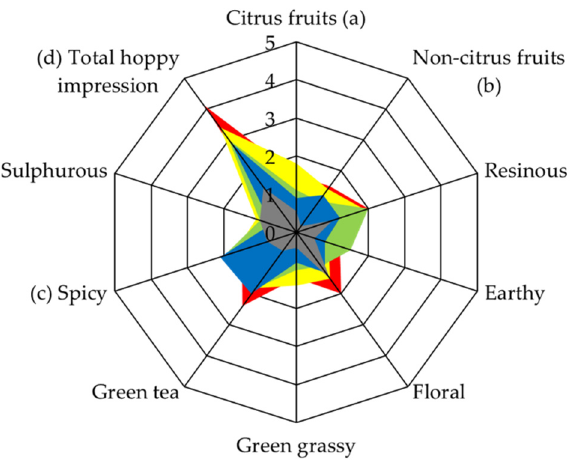
Figure 2. Quantitative descriptive sensory analysis of beers dry-hopped with Portuguese wild hops. Each beer score is represented by a different colour. PT05 (blue), PT11 (red), PT14 (yellow), PT15 (green), and non-dry-hopped beer in the grey area. Data from sensory analysis performed by trained panellists are presented as means (floral) in normal distribution or medians (other attributes) in non-normal distribution. Two independent samples t-test and Mann-Whitney test were applied to detect which attributes were significant in normal and non-normal distributions. Letters between brackets represent that ( a ) PT14, ( b ) PT11, ( c ) PT05, and ( d ) all hops presented significant statistical differences ( p < 0.05) of the attribute in comparison with non-dry-hopped beer.